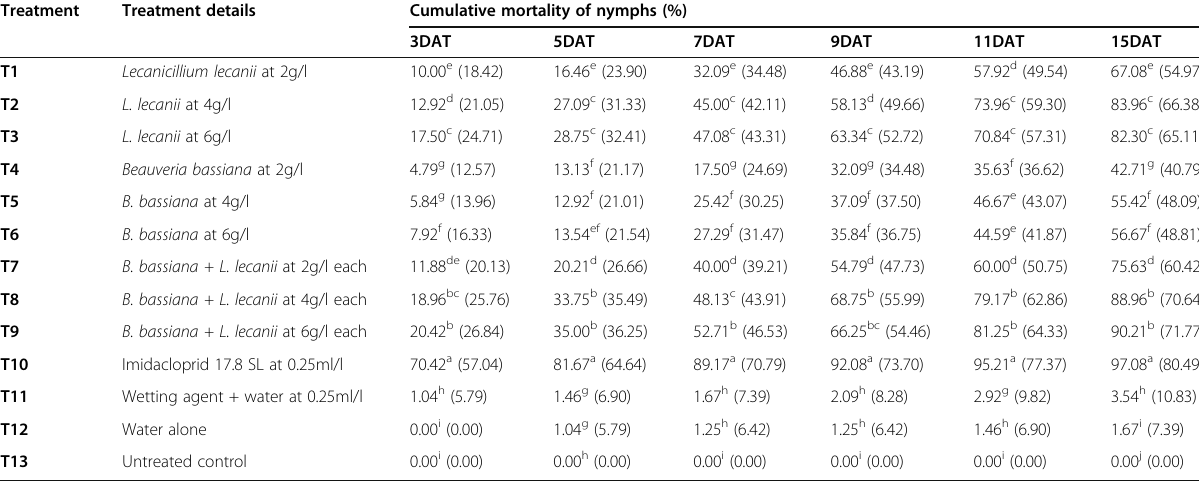
Table 2 Efficacy of entomopathogenic fungi against Maconellicoccus hirsutus under laboratory condition Treatment Treatment